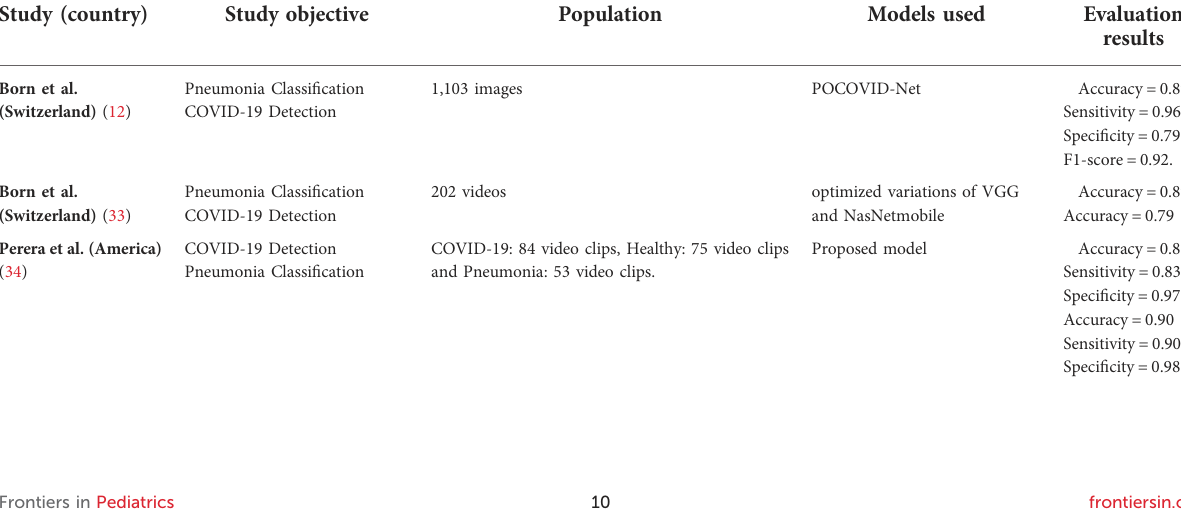
TABLE 4 Studies using LUS based on CNNs for pneumonia of COVID-19. Study